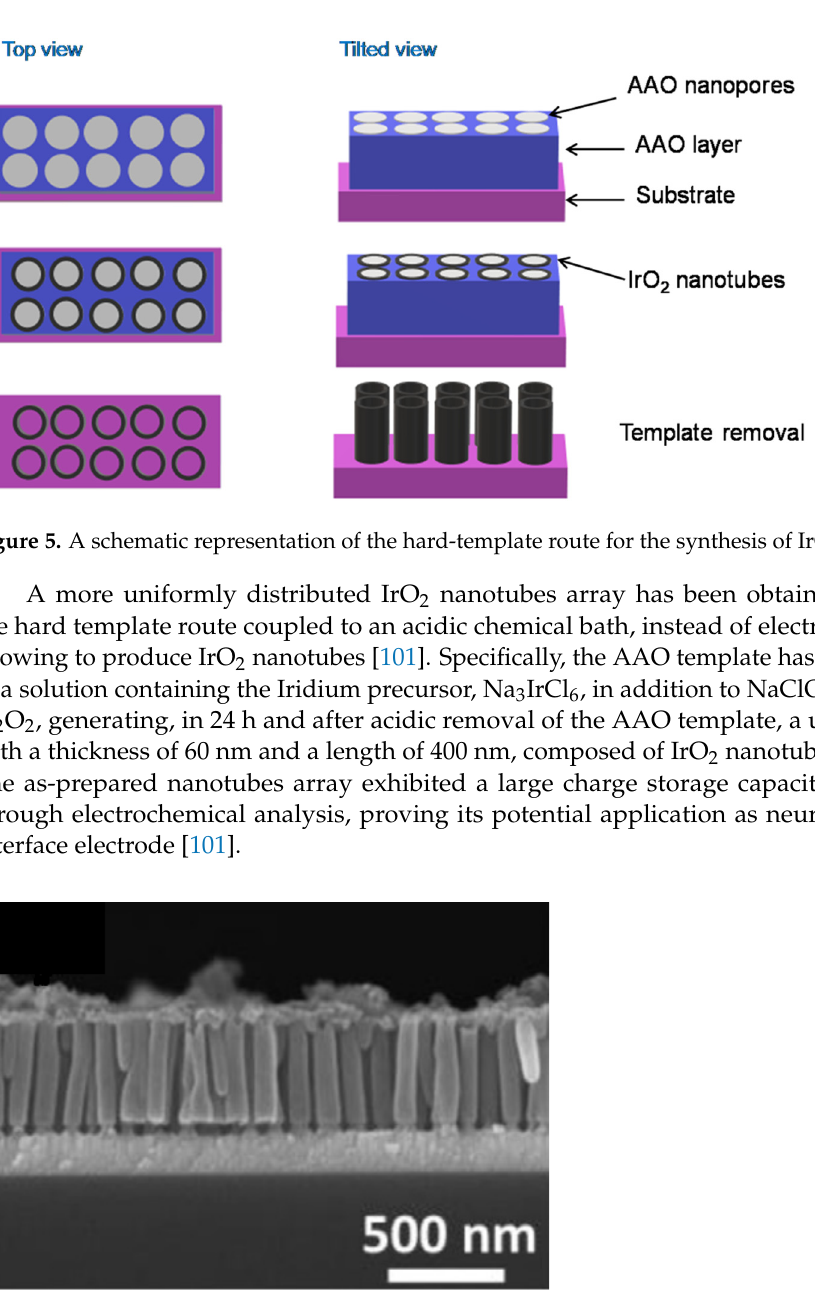
Figure 6. SEM image of IrO 2 nanotubes array (Reprinted/adapted with permission from Ref. [101]).